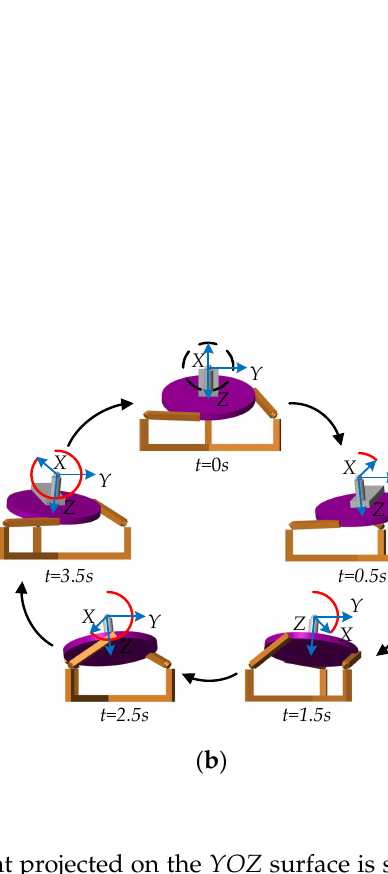
( c ) Figure 10. ( a ) Simulation result of circular trajectory ; ( b ) the error curve of the trajectory; ( c ) the curve of the motor-driving torque. 5. Prototype Experiment In the early stage of the rehabilitation process, the passive rehabilitation training mode is mainly used to train the range of motion of the patient’s ankle joint. Since the